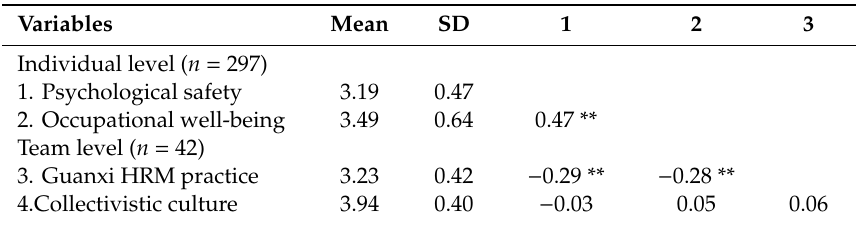
Table 1. Means (M), standard deviations (SD) and correlation coe ffi cients.